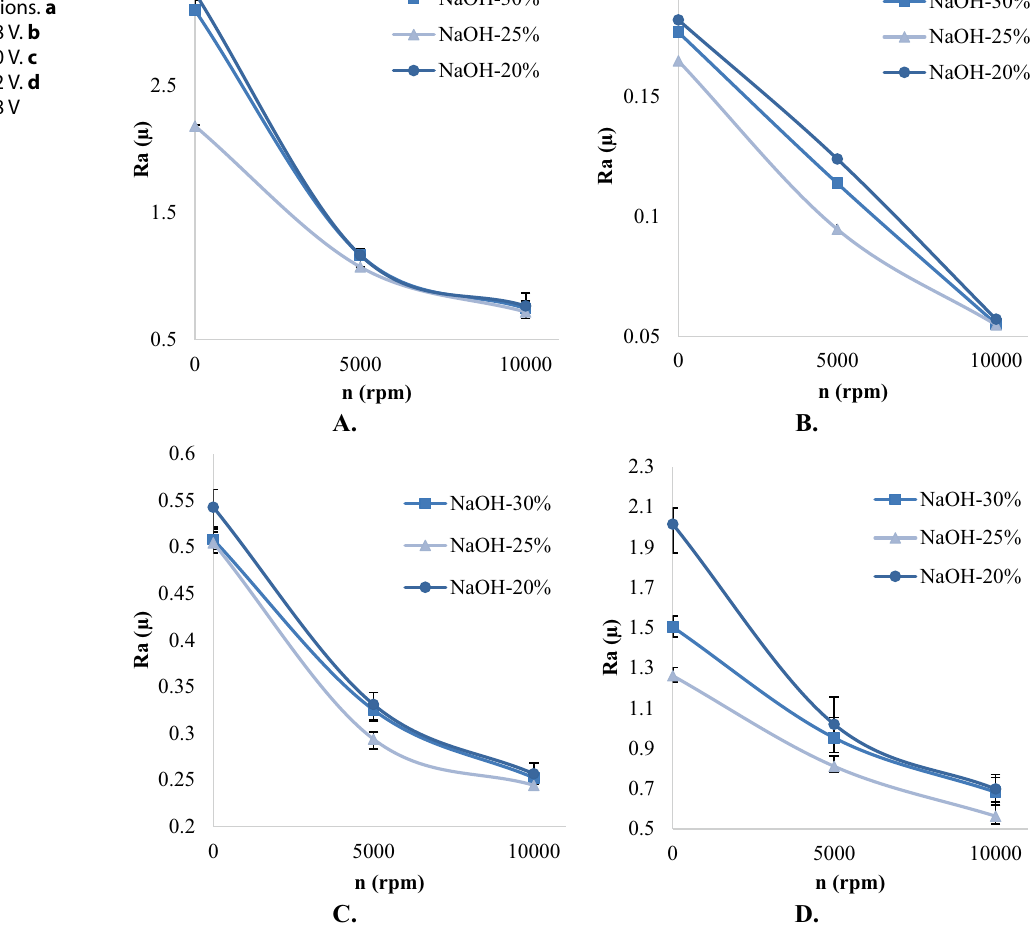
Fig. 7 Effect of electrolyte con- centration on surface rough- ness in different conditions. a V = 1.2 mm/min - U = 38 V. b V = 1.2 mm/min - U = 40 V. c V = 1.2 mm/min - U = 42 V. d V = 0.6 mm/min - U = 38